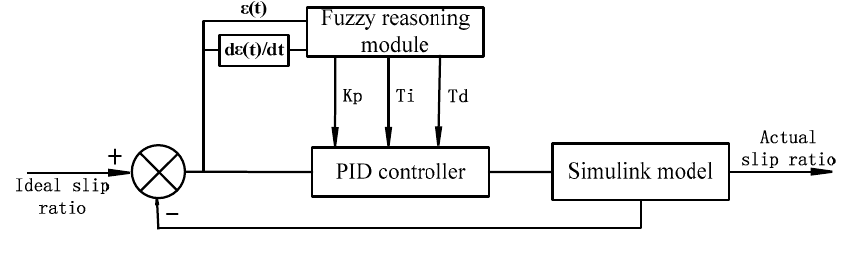
Figure 5. Braking force distribution by following the minimum current impact. ( a ) Braking force distribution strategy flow chart; ( b ) Braking force distribution curve.